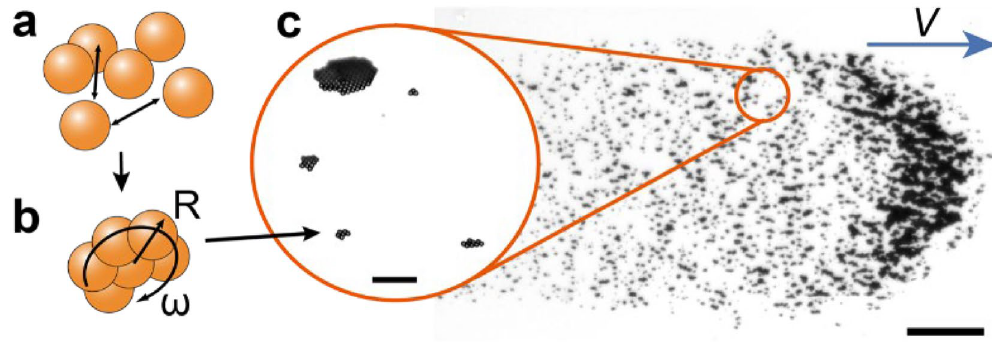
Figure 1. Upon application of a rotating magnetic field (a) individual 4.5 µm beads form into (b) µwheels which subsequently form into (c) swarms. Inset scale = 50 µm. Swarm scale = 300 µm.